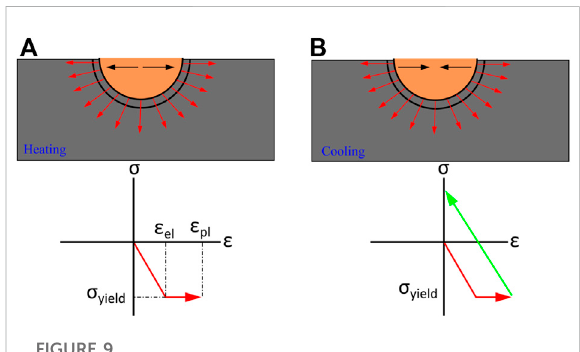
FIGURE 9 Residual stresses generated in substrate during cool down phase model during (A) heating and (B)